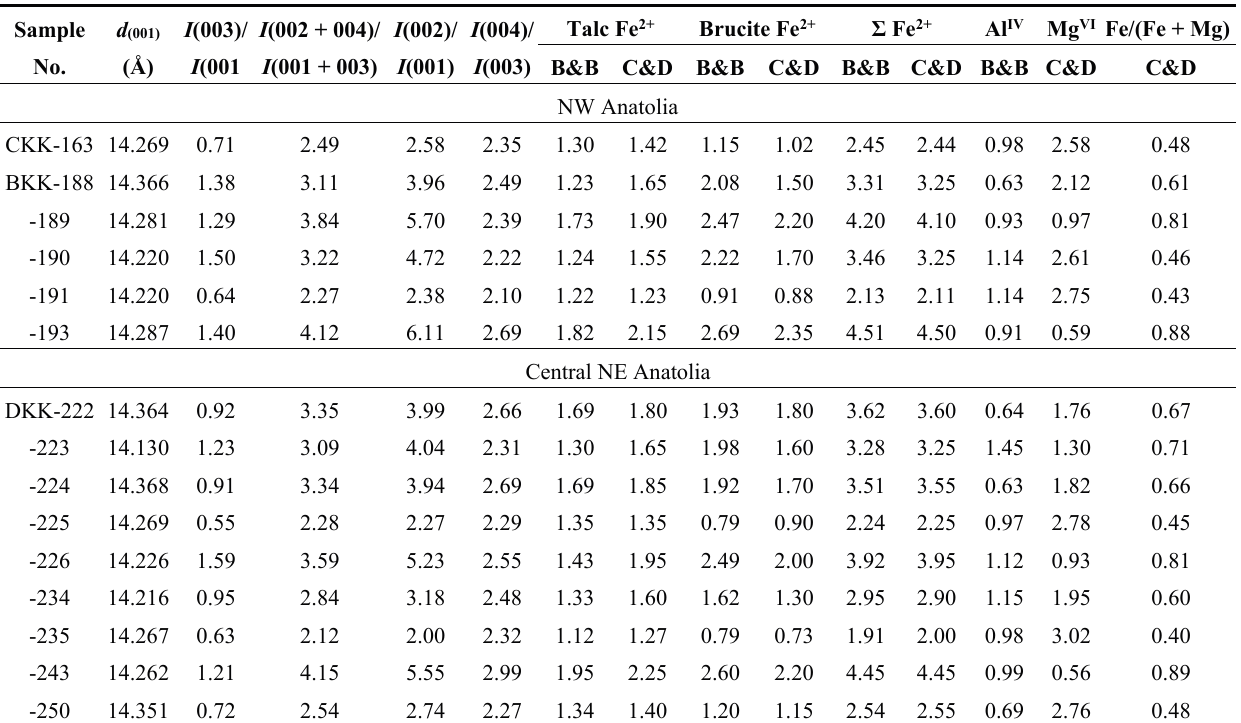
Table 4. XRD basal reflections and chemical compositions of chlorite minerals in the Upper Karakaya Complex units (subgreenschist facies). B: Brindley [42], B&B: Brindley and Brown [43], C&D: Chagnon and Desjardins [44]), Al IV = Al VI and Mg = 6 − (Fe + Al IV